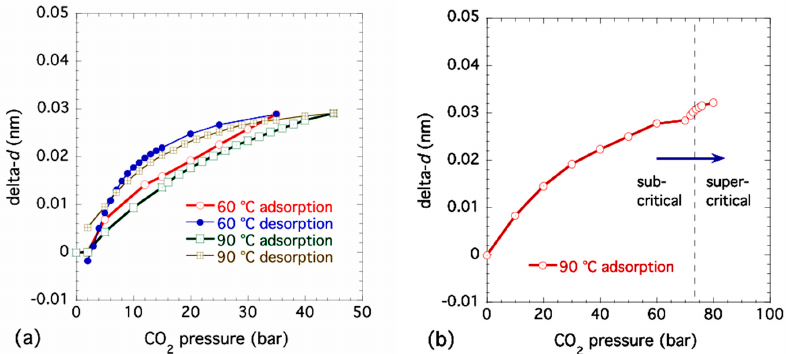
Figure 5. Changes in Bpene linker d -spacing with CO 2 pressure for (a) adsorption and desorption at 60 °C and 90 °C under subcritical conditions and (b) adsorption only for pressures extending to 80 bar in the supercritical CO 2 regime at 90 °C. Peak fit uncertainties are smaller than the data points.